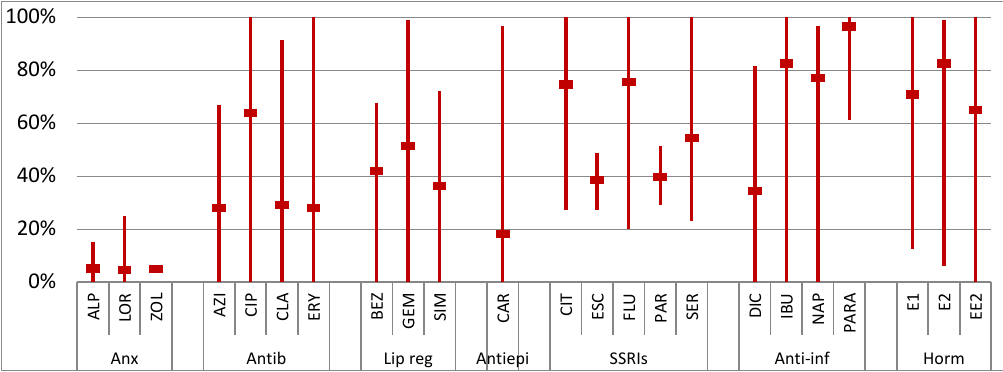
Figure 1. Minimum, maximum and average removal efficiencies in WWTPs (%). Anx — anxiolytics, Antib — antibiotics, Lip reg — lipid regulators, Antiepi — antiepileptics, SSRIs — selective serotonin reuptake inhibitors, Anti-inf — anti-inflammatories and Horm — hormones [3,5,13,16,18,51,59,63,67,68,71,78 – 82,85,87,88,92,99,102 – 132].